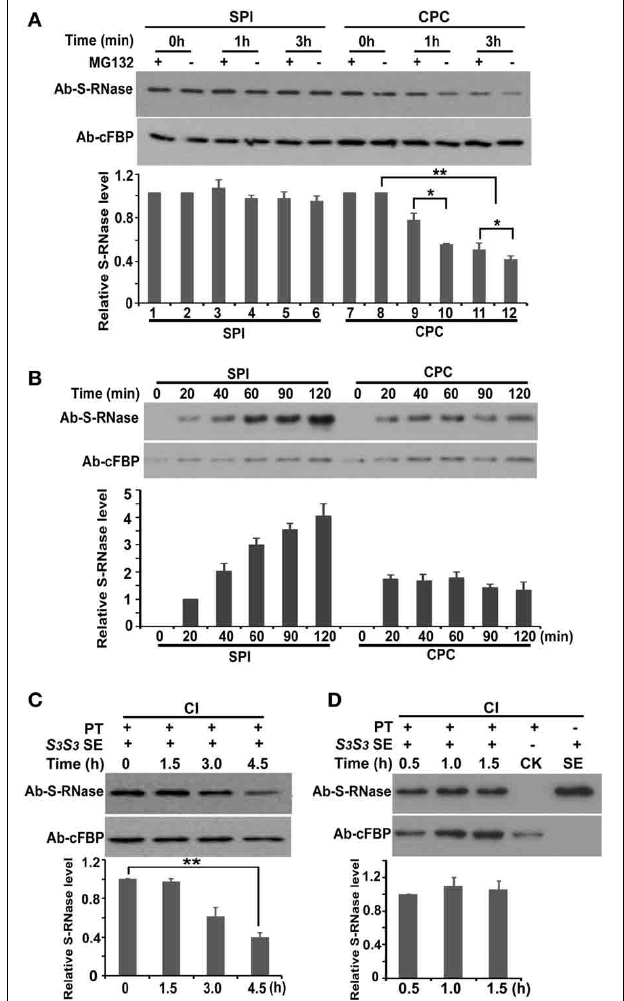
FIGURE 5 | SCF SLF directly mediates non-self S-RNase degradation by the 26S proteasome pathway. (A) Time course analysis of PhS 3L -RNase levels in pulse challenged SPI ( S 3L ) and CPC ( S v ) pollen tubes in conjunction with ( + ) or without ( − ) MG132 treatment. (B) Time course analysis of PhS 3L -RNase accumulations in continuously challenged SPI ( S 3L ) and CPC ( S v ) pollen tubes. In vitro germinated S 3L and S v pollen tubes were continuously treated with S 3L S 3L style extract. PhS 3L -RNase levels in pollen tubes were monitored by western blot analysis. cFBP was detected as loading control. (C) Time course analysis of PhS 3 -RNase levels in pulse challenged pollen tubes with stylar extracts. The pollen tubes were derived from the transgenic plants exhibiting competitive interaction (CI) between the transgene PhS 3L -SLF1 and S 3 haplotype. PhS 3 -RNase was detected by western blot to monitor its dynamics in S 3 / PhS 3L -SLF1 pollen tubes. (D) Time course analysis of PhS 3 -RNase levels in continuously challenged pollen tubes with stylar extracts. The transgenic S 3 /PhS 3L -SLF1 pollen tubes were continuously treated with S 3 S 3 style extract and monitored for S 3 -RNase level through the time course. CK indicates pollen tubes before treatment. cFBP was detected as loading control. PT, S 3 /PhS 3L -SLF1 pollen tube; SE, style extract. Column charts in both (A–D) show quantitative S-RNases levels determined by Quantity One software using three replicates. T tests were done between the designated lanes. Single and double asterisks denote significant and extremely significant difference,